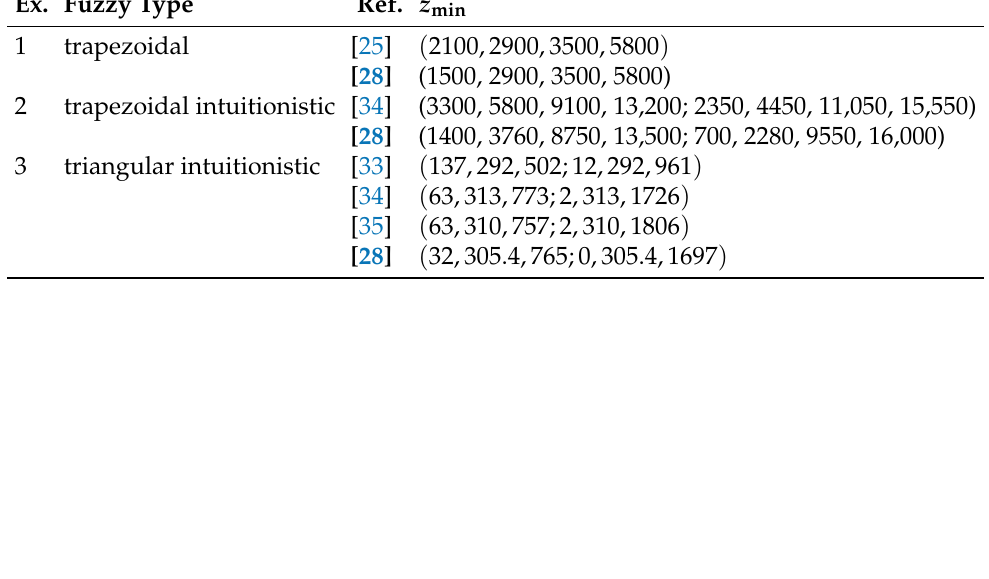
Table 1. Comparative numerical results for full fuzzy and full intuitionistic fuzzy TPs. Ex. Fuzzy